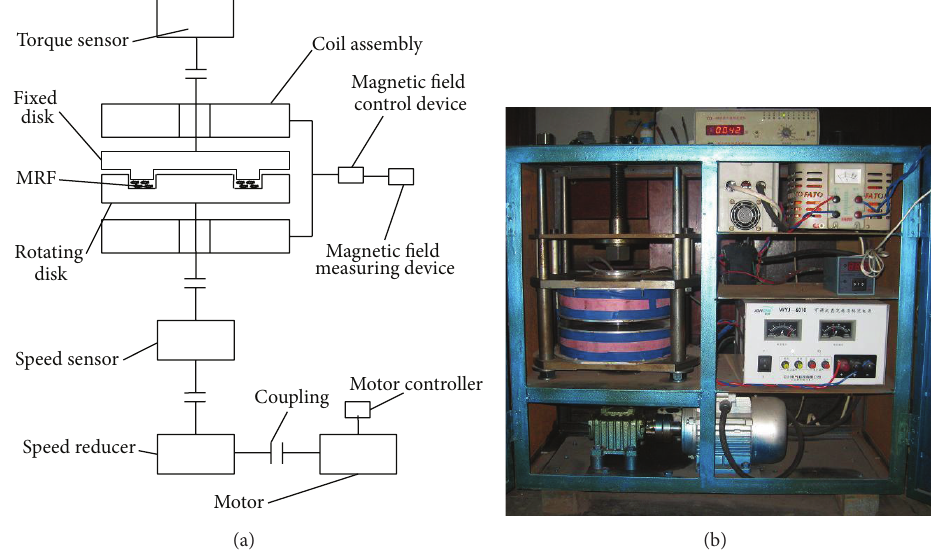
Figure 8: The performance experimental device for MR fluid rheological properties.